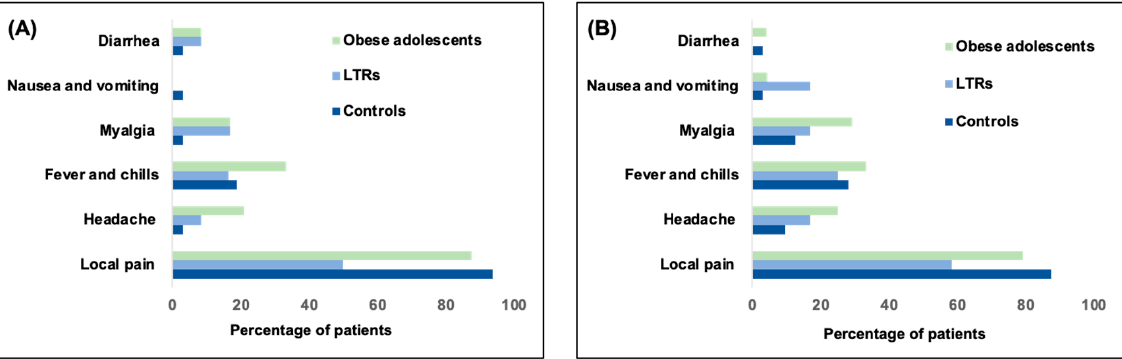
Figure 3. Development of adverse events after the first ( A ) and second ( B ) dose of vaccination within 7 days.